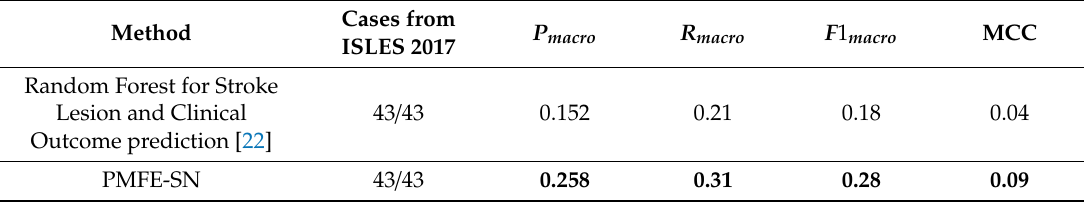
Table 4. Comparison of per class precision, recall, accuracy, and area under the curve (AUC) of state- of-the-art and PMFE-SN on leave one cross-out testing.